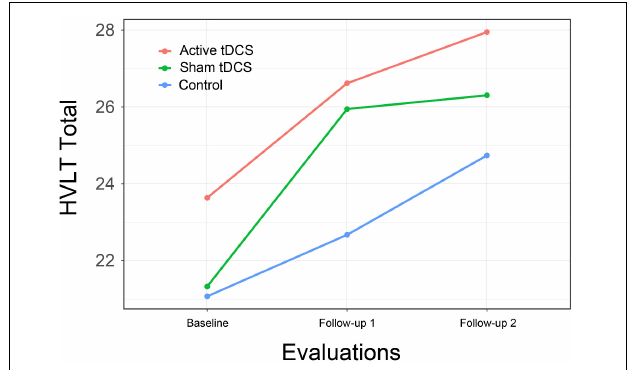
FIGURE 6 | Hopkins verbal learning test total score, Part B by Group and Time.